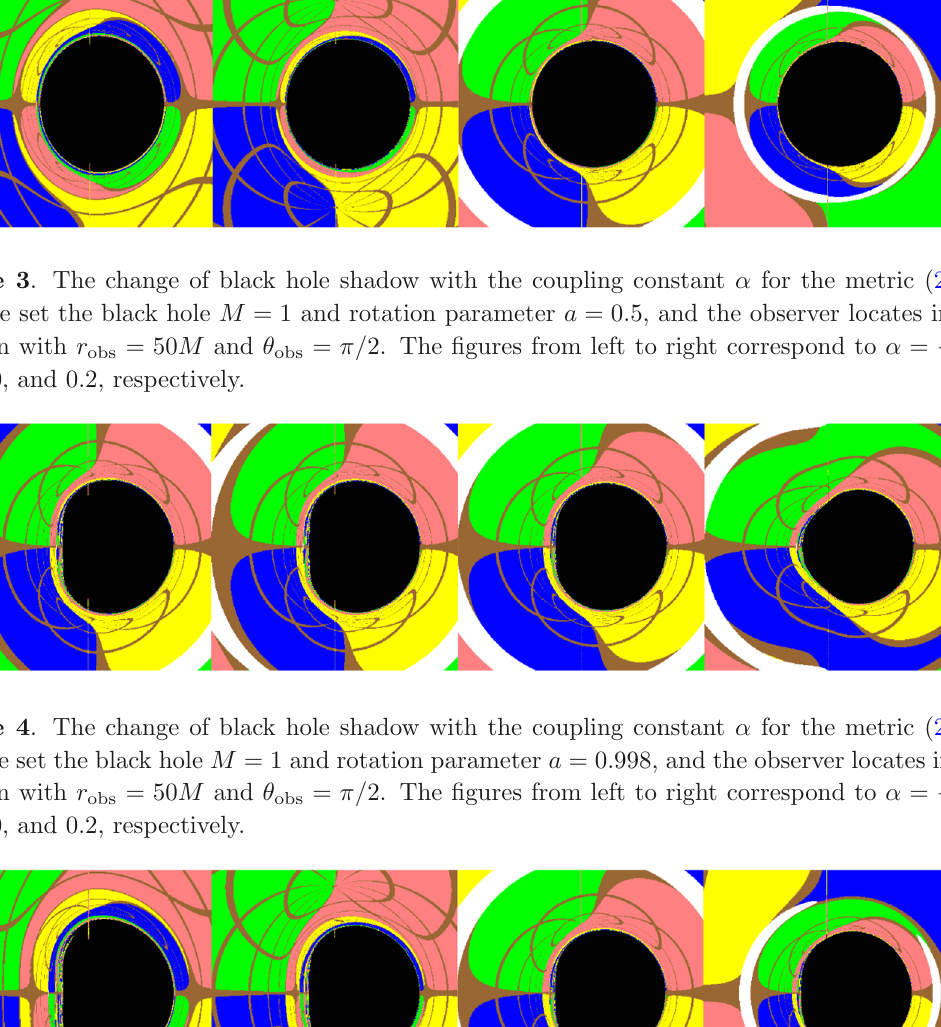
Figure 5 . The change of black hole shadow with the coupling constant α for the metric (2.22). Here we set the black hole M = 1 and rotation parameter a = 0 . 998, and the observer locates in the position with r obs = 50 M and θ obs = π/ 2. The figures from left to right correspond to α = 0 . 2, 0, and 0 . 2, −